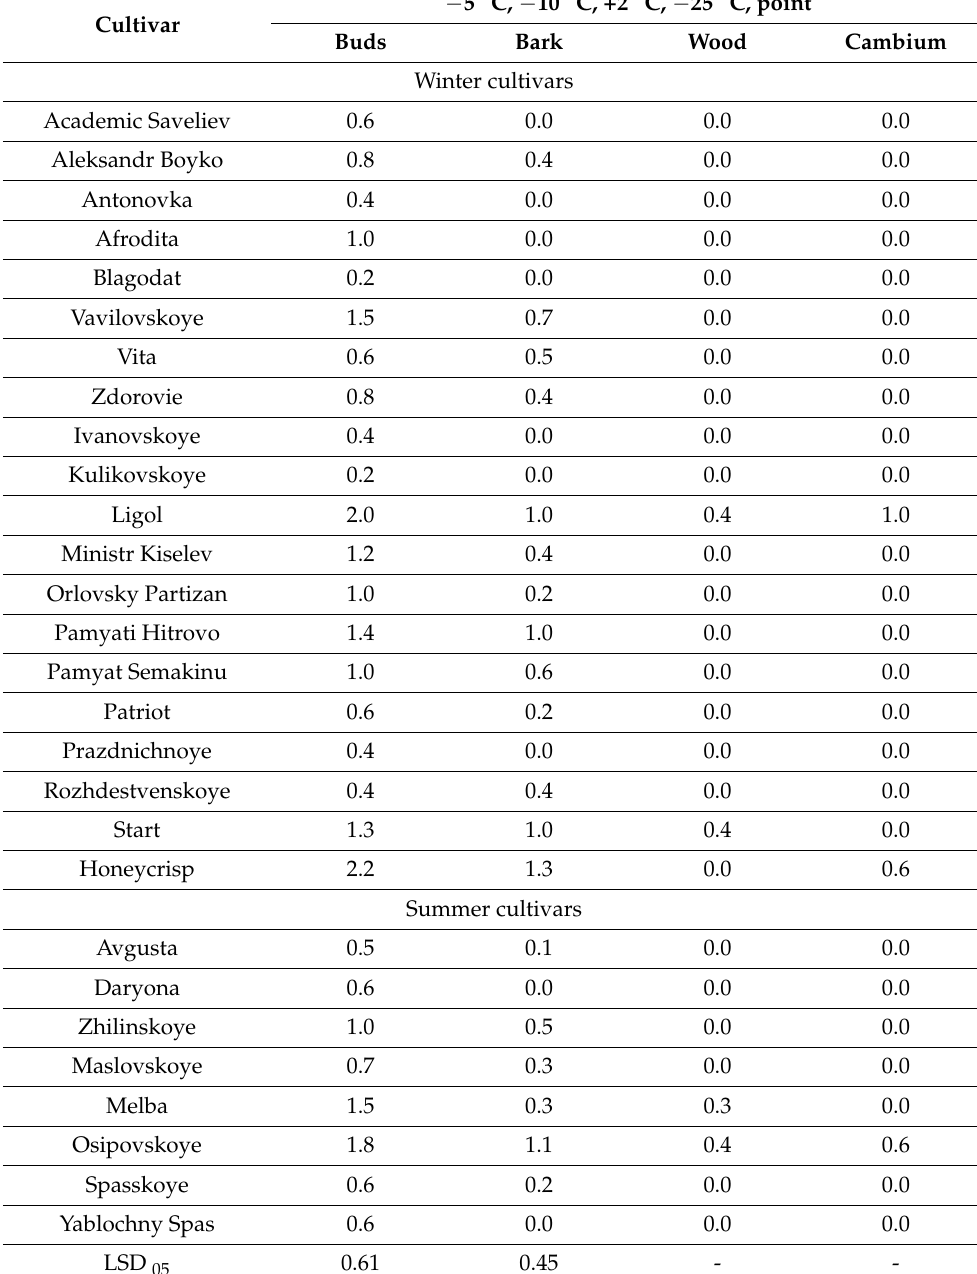
Buds and bark in ‘Vavilovskoye’, ‘Ministr Kiselev’, ‘Start’ and ‘Osipovskoye’